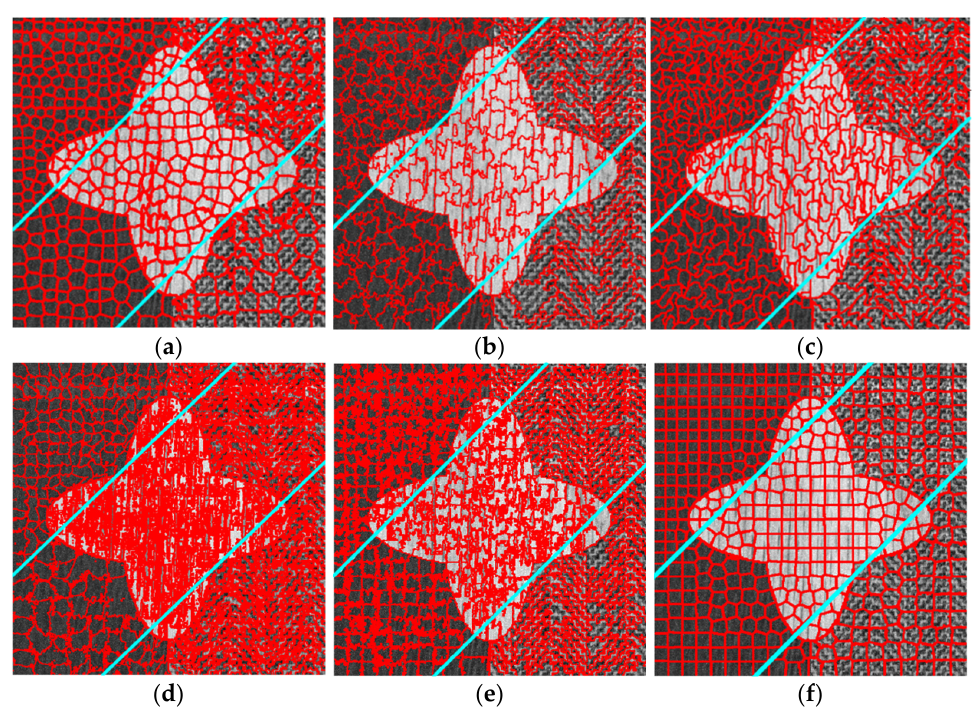
SI . ( a ) SLIC, ( b ) SNIC, ( c ) SEEDS, ( d ) 1